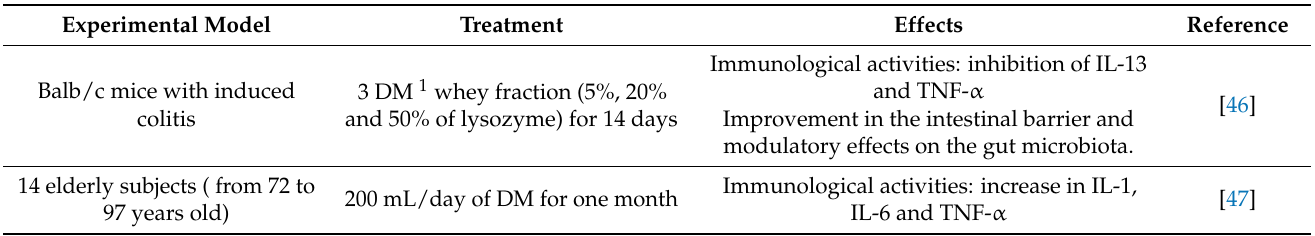
Table 4. In vivo randomized controlled studies on the beneficial effects of donkey